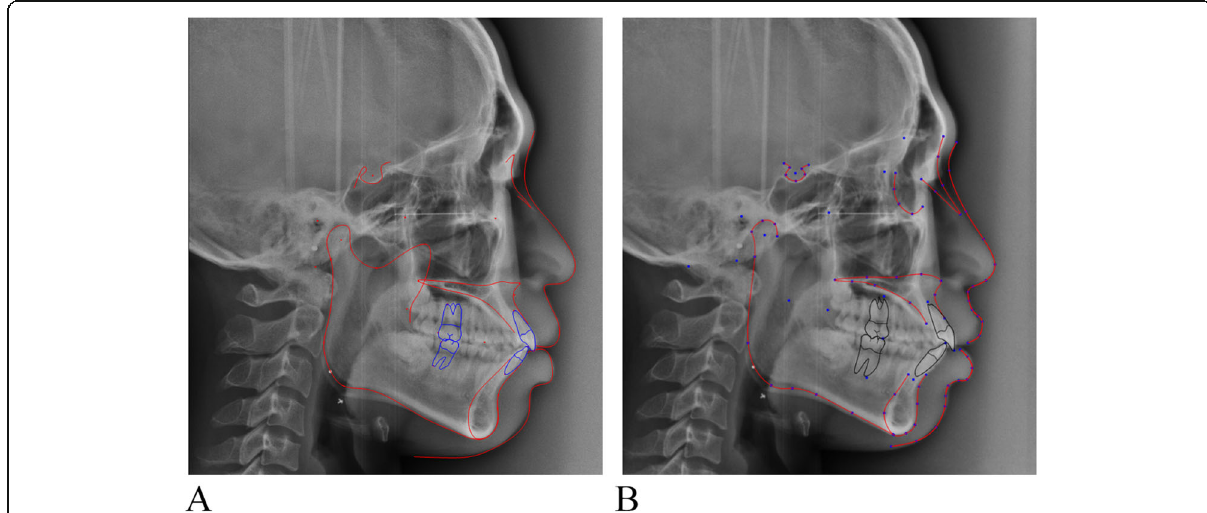
Fig. 1 Cephalometric analysis using conventional ( a ) and AI ( b ) methods